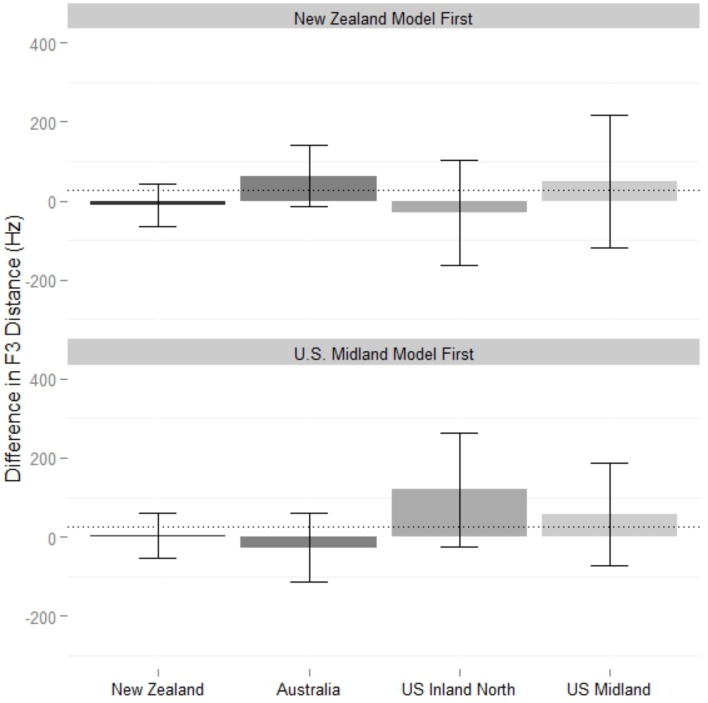
Difference in F3 distance between New Zealand shadowers and their model across baseline and shadowed tokens on NEAR words. Top panel: When participants began with the New Zealand block. Bottom panel: When participants begin with U.S. Midland block. Error bars represent 95% confidence. Dotted line represents grand mean of model.